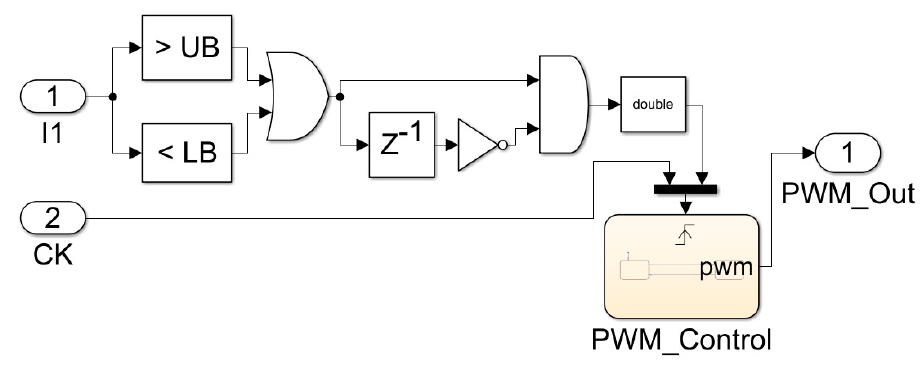
Figure 5. Simulink model of the subsystem FPGA.